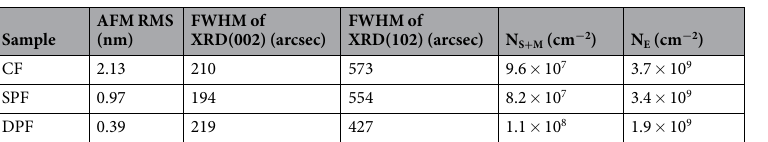
Table 1. Crystal properties of the three AlN samples. N S + M is the calculated density of screw and mixed dislocation; N E is the one of edge